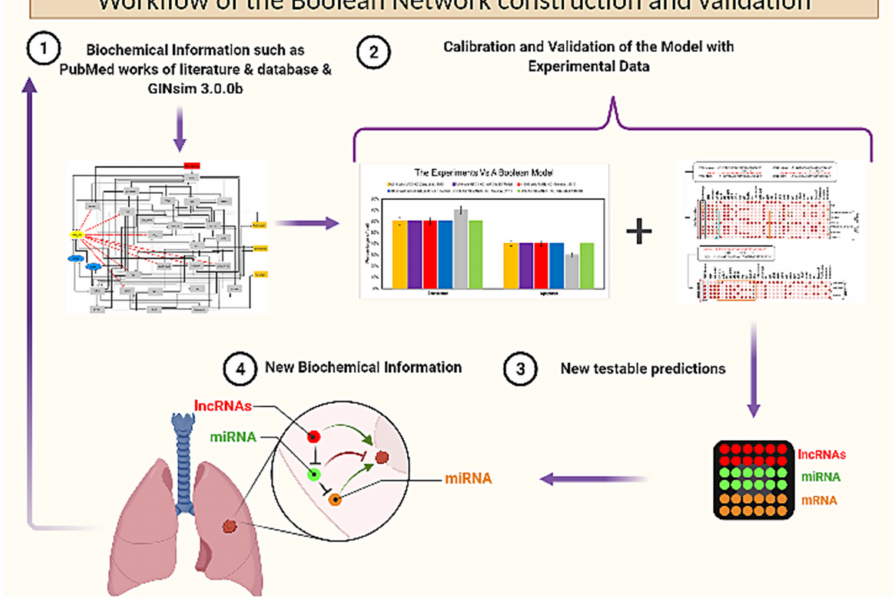
Figure 5. Workflow of the model construction and validation by the cycle of 1 to 4-steps. Step 1, The model was simulated using GINsim 3.0.0b, based on the biochemical information provided by PubMed works of literature and databases. In Step 2, we verified the coherence between the outcome produced by the perturbed nodes and experimental observations using the same